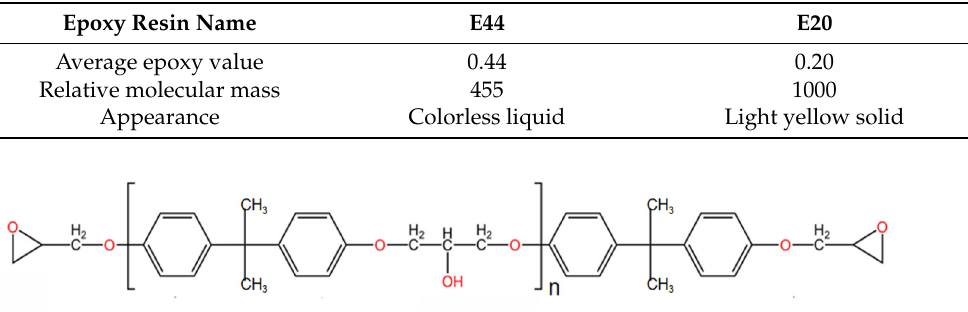
Figure 1. Molecular structure of bisphenol A epoxy resin.